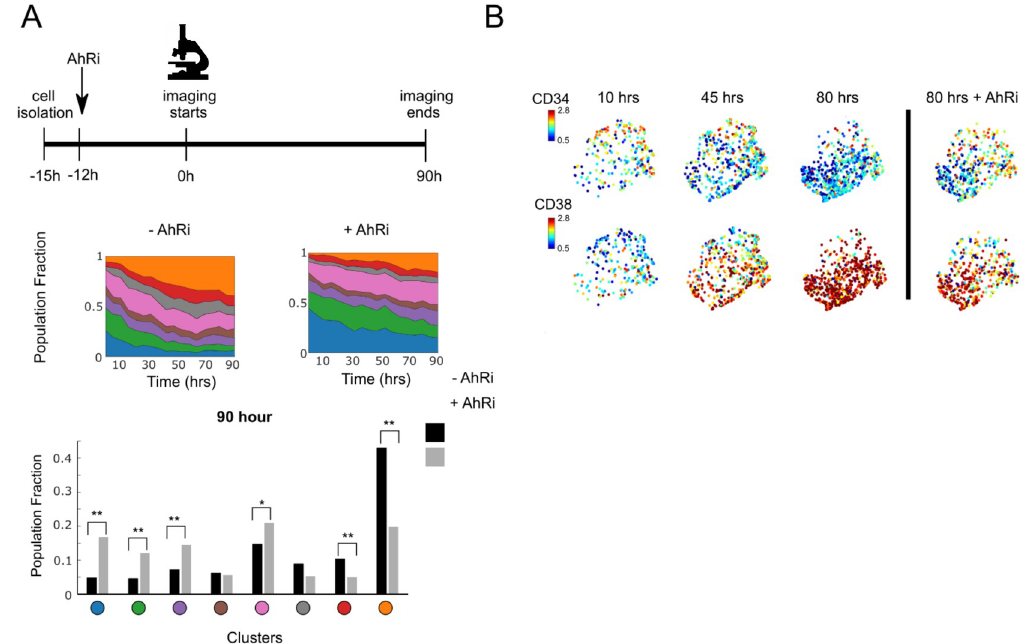
Fig 5. Population dynamics of identified morphological states. (A) Population fraction dynamics over time for each morphological cluster with (right) or without (left) AhR inhibitors (top). Population fraction contribution of each cluster at the last time point of the culture (bottom). Comparisons of the population fraction with and without AhR inhibitor were performed using the Chi-Square test for the dependency between the AhRi treatment and a cell’s cluster identity. �� : p < 0.001, � : p < 0.05 (B) UMAP showing CD34 and CD38 expression levels at different time points, in the presence or absence of AhRi.